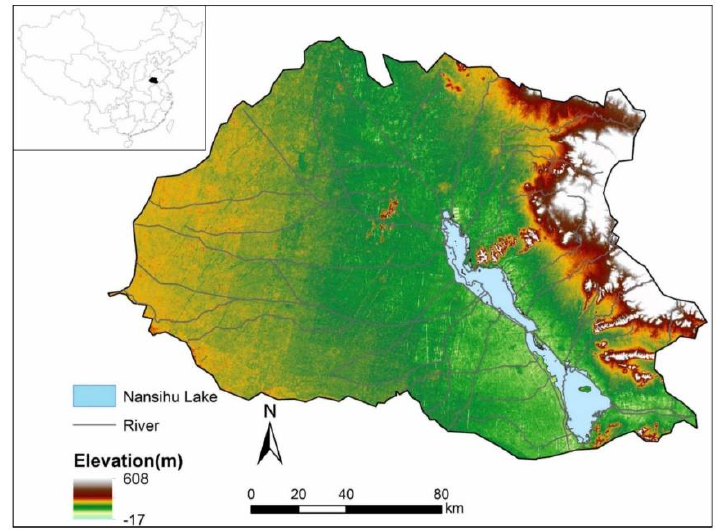
Figure 1. Location map of the Nansihu Lake Basin (NLB).